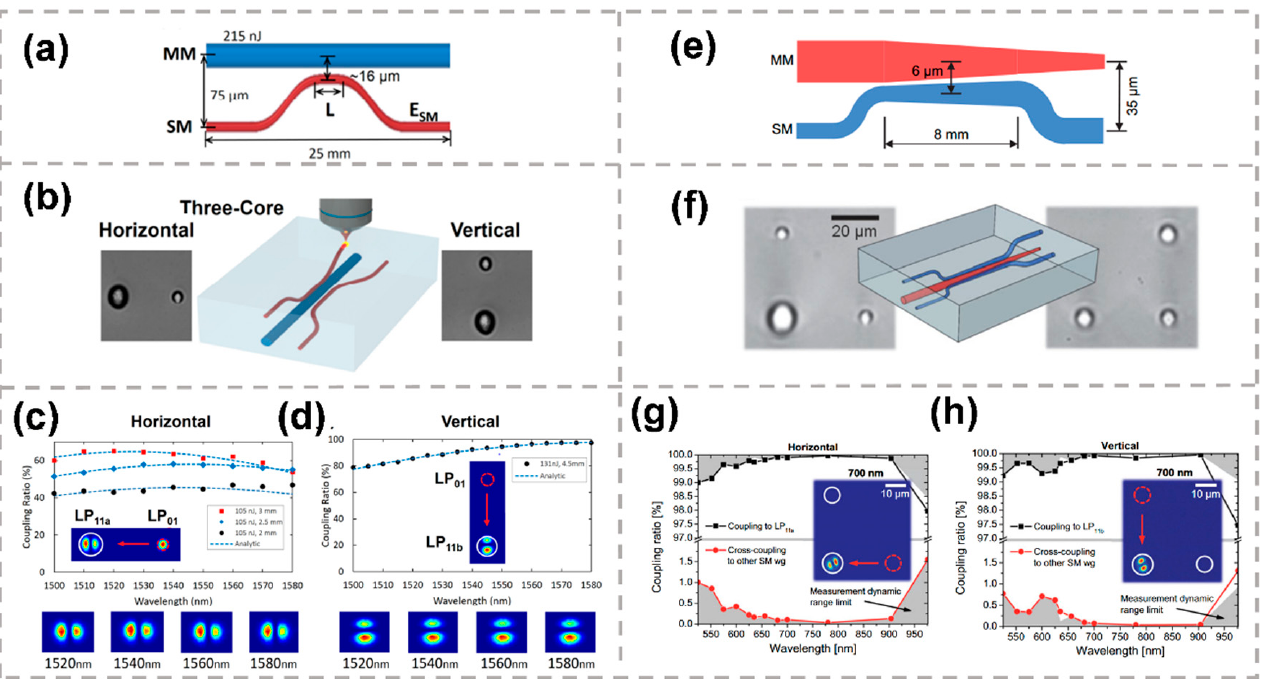
Figure 10. ( a ) Schematic of the ( a ) horizontal and vertical two-couplers, each comprising a multimode and single-mode core [118]. ( b ) Brightfield microscope images of the end-faces (writing laser incident from the top) and 3D sketch of the fabricated coupler [119]. The measured coupling ratios for the ( c ) horizontal and ( d ) vertical couplers as compared with approximate analytic models. The coupling ratios of two other horizontal couplers written using the same pulse energy but with different interaction length are also shown. The LP a and LP b mode profiles are shown in the inset [119]. ( e ) Schematic of a two-core tapered mode-selective coupler comprising a tapered multimode and a counter-tapered single-mode waveguide [119]. ( f ) Brightfield microscope images of the end-faces (writing laser incident from the top) and 3D sketch of the fabricated coupler [119]. ( g ) Coupling and cross-coupling ratios when injecting light into the horizontal single-mode waveguide as a function of wavelength [119]. ( h ) Coupling and cross-coupling for light injection into the vertical single-mode waveguide [119]. Reproduced from [118] with permission of the Optica Publishing Group, 2022. Reproduced from [119] with permission of the John Wiley and Sons, 2022.